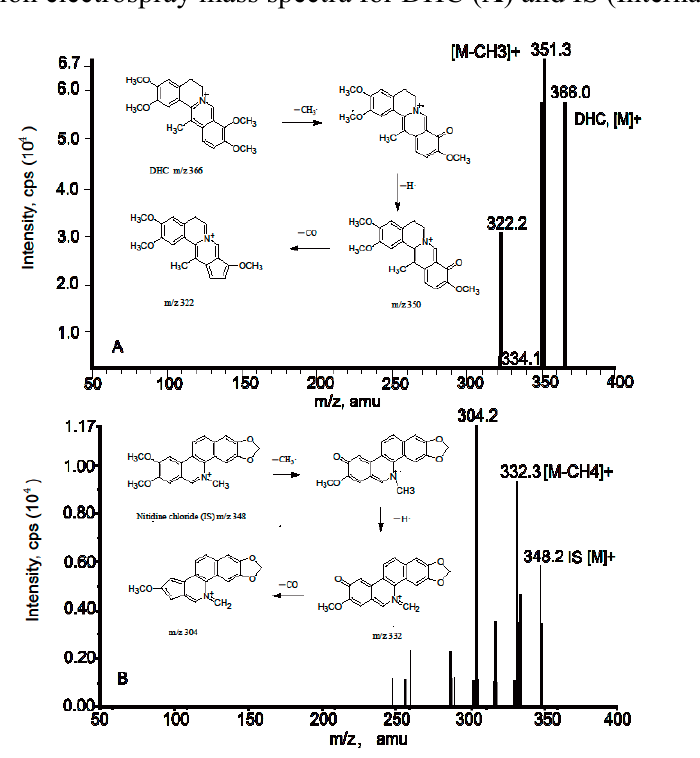
Figure 3. Positive-ion electrospray mass spectra for DHC ( A ) and IS (Internal Standard) ( B ).